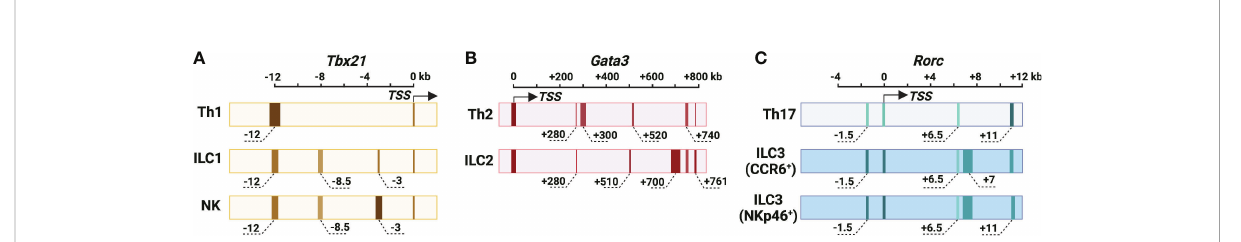
FIGURE 1 Cis-regulatory elements at the murine Tbx21 , Gata3 and Rorc gene loci. (A) The chromatin accessibility of the Tbx21 gene locus in Th1 cells, NK cells and ILC1s. Tbx21 promoter region is partially accessible in Th1 cells, NK cells and ILC1s. Tbx21-CNS-12 is the major highly accessible site